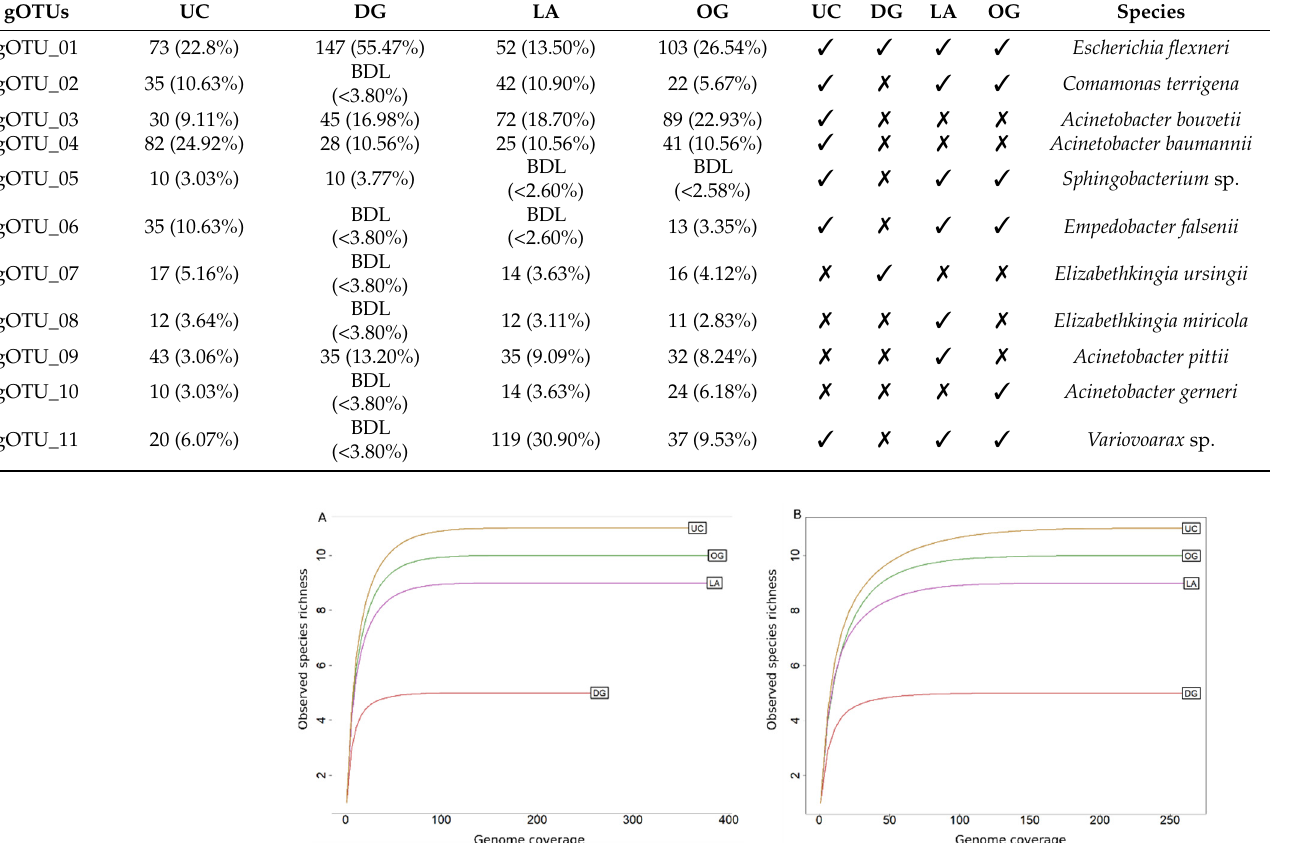
Table 1. Genome coverage of genome operational taxonomic units (gOTUs) per sub-community. All gOTUs in the same cluster were classified with the same taxonomy. Mapping the reads from all libraries to the gOTUs was done irrespective of their recovery. We removed gOTUs with less than ten times coverage and labeled them as below the detection limit (BDL). The marks indicate in which library the gOTUs were recovered. The numbers in parenthesis indicate the coverage times of each gOTU in the libraries expressed in percentages. (DG: Dominant sub-community; LA: Low abundant sub-community; OG: Outer gate sub-community; UC: Unsorted sub-community).